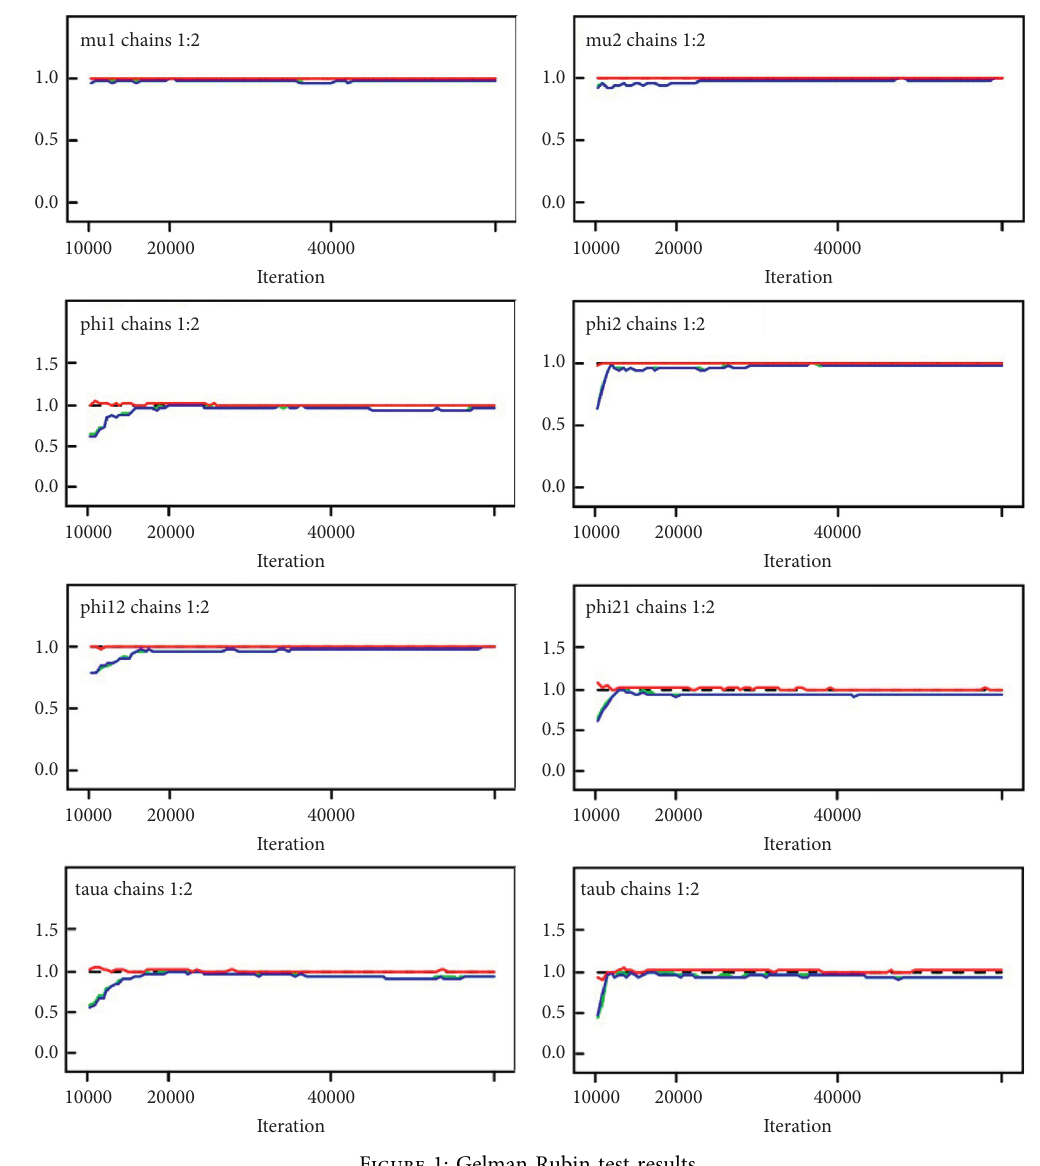
Figure 1: Gelman Rubin test results.